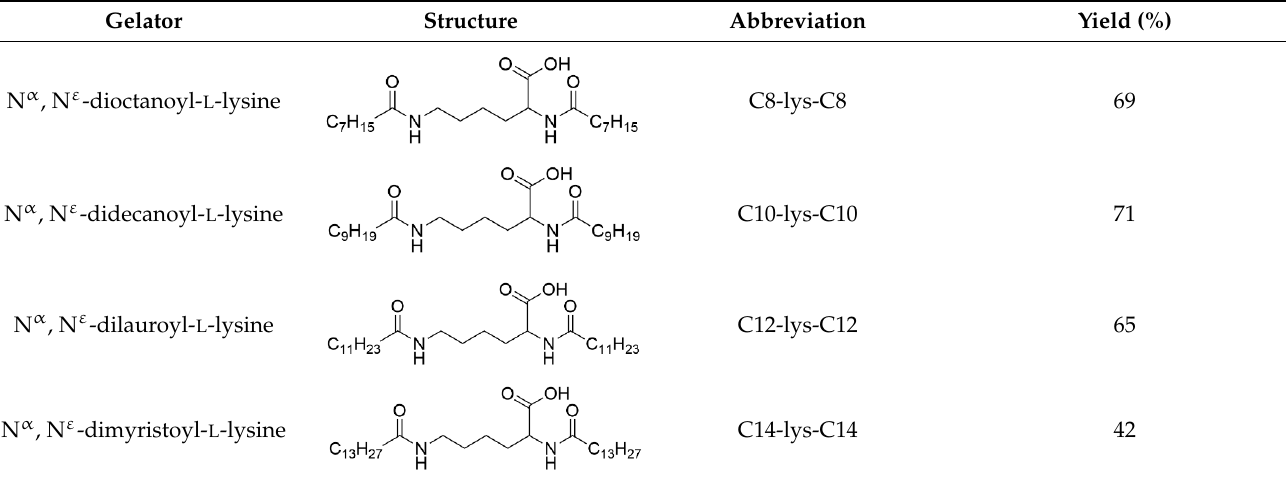
Table 1. Product list of four N α , N ε -diacyl lysine-based gelators.